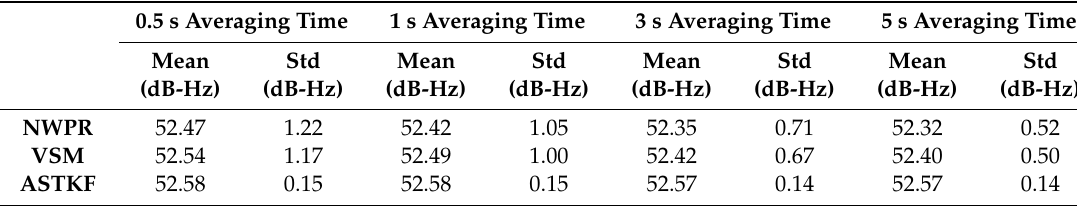
Table 3. Strong signal C / N 0 estimation statistics.